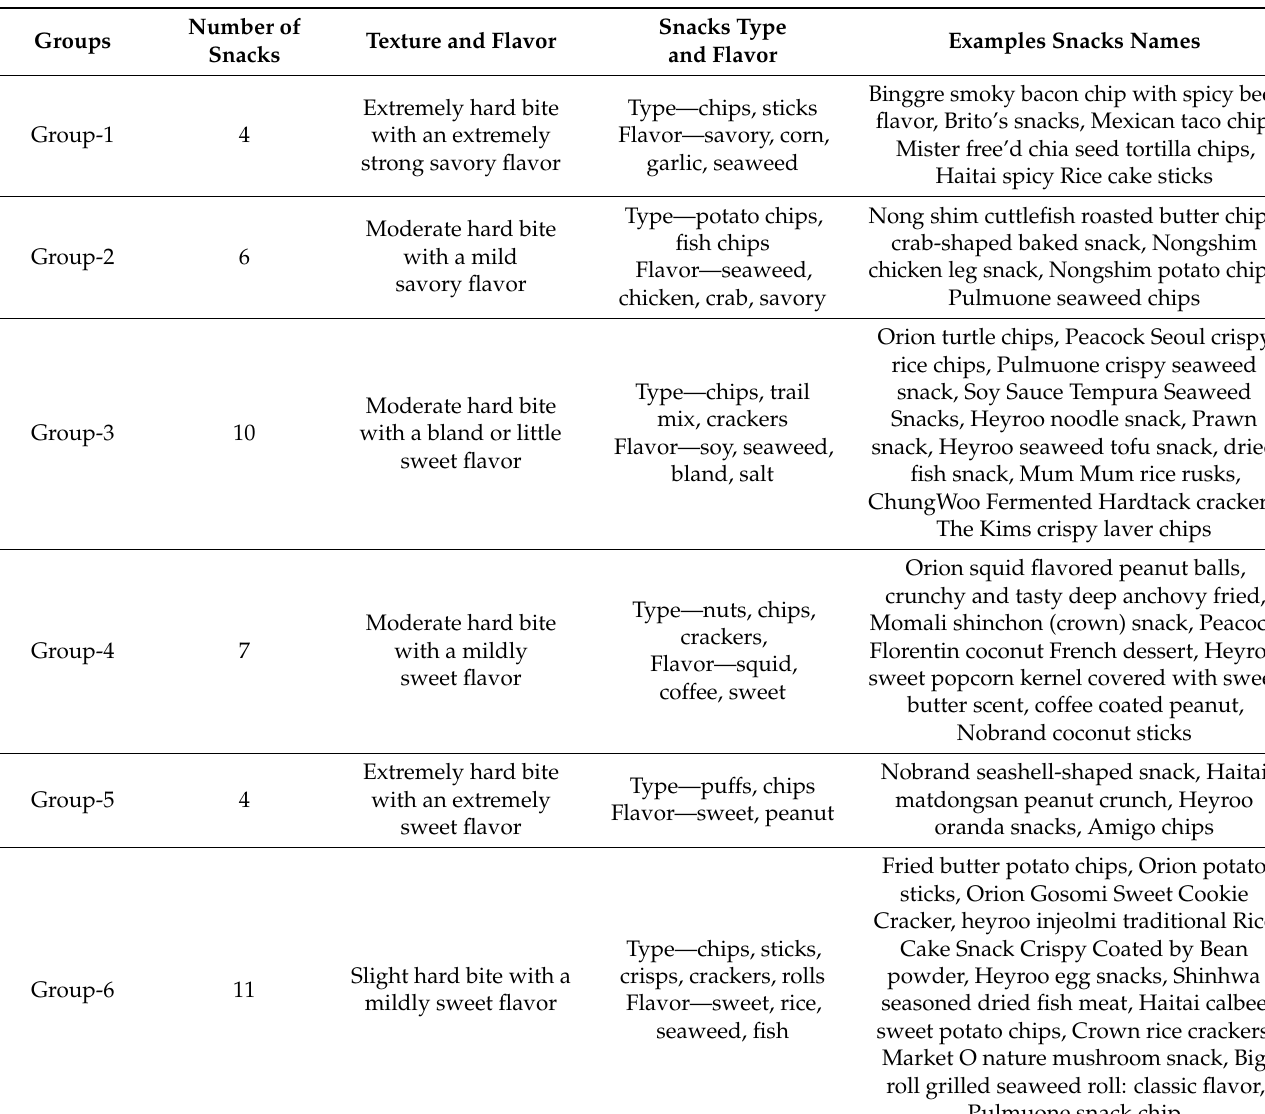
Table 4. Group identified in the projective mapping of the SK snacks. Group number, number of snacks in each group, snack type, texture, flavor, and snack